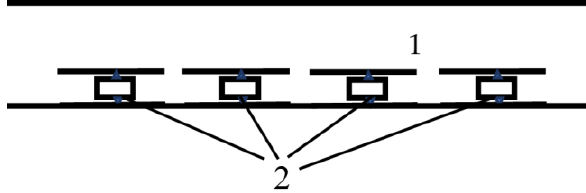
Figure 3. Lining of the waveguide 1 with dipole resonators 2.